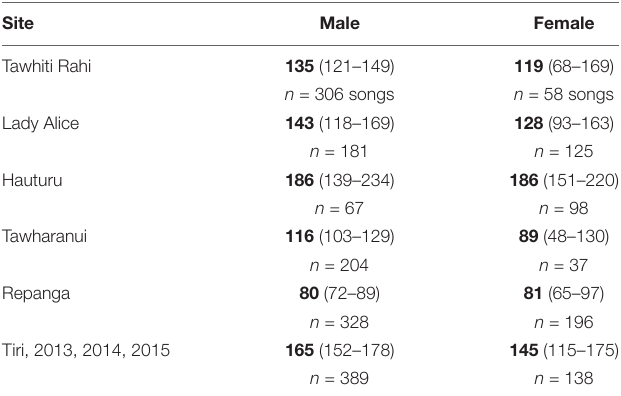
Estimated number of syllable types at 500 songs, for male and female population sectors at each site. Point estimates are in bold, 95% confidence intervals are in brackets. Calculated with the statistical software Estimate S (Colwell,